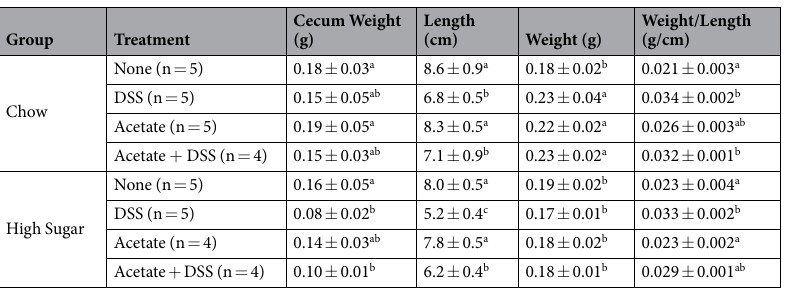
Table 1. Colon length and tissue weights in chow and high sugar fed mice following DSS. Values are means ± SEM. Labeled means in a row without a common letter differ. p <